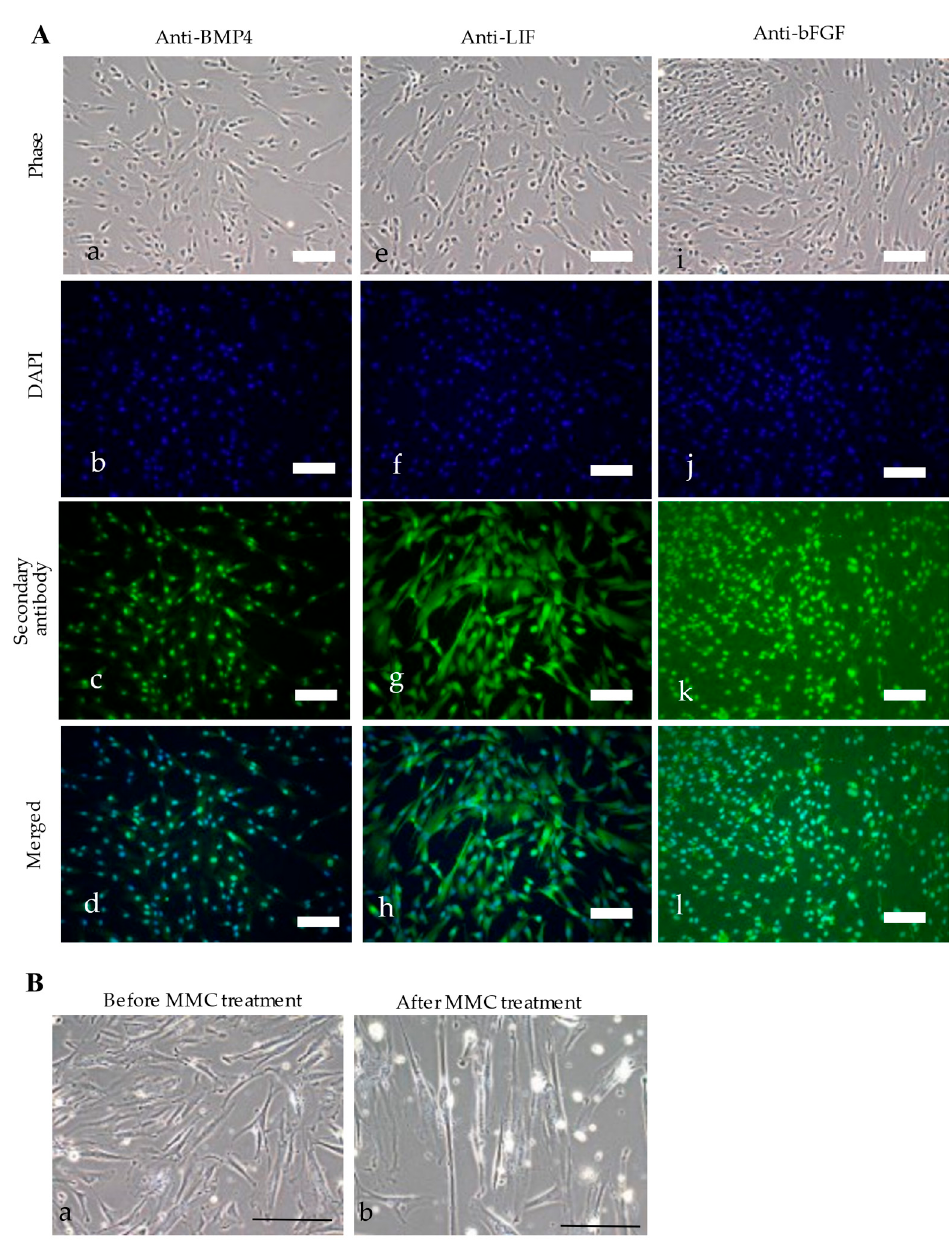
Figure 2. Characterization of TR-2 feeder cells. ( A ) Immunocytochemical staining of TR-2 feeder cells. Cells were immunostained with (a–c), and (d) anti-BMP, (e–h) anti-LIF, or (i), (j), (k), and (l) anti-bFGF antibodies. Scale bars = 50 µm. ( B ) Morphological changes in TR-2 feeder cells (a) before and (b) 35 d after MMC treatment. Scale bars = 100 µm. bFGF: basic fibroblast growth factor; BMP4: bone morphogenetic protein-4; DAPI: 4 ′ ,6-diamidino-2-phenylindole; LIF: leukemia inhibitory factor; MMC: mitomycin-C.